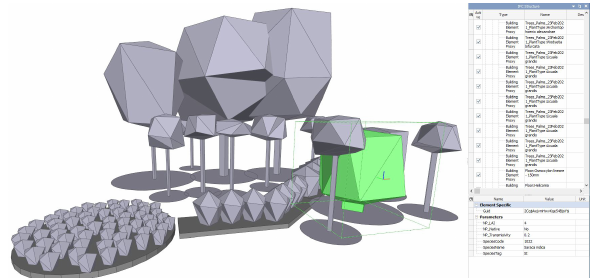
Figure 7. The placeholders are replaced with information-enriched 3D vegetation models.